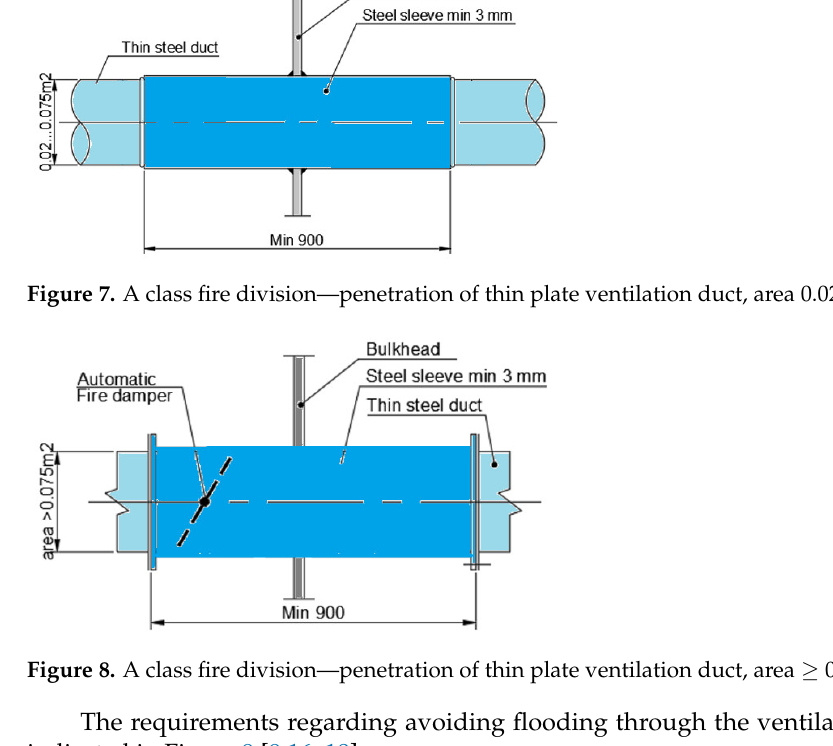
Figure 6. A class fire division—penetration of thin plate ventilation duct, area ≤ 0.02 m 2 .